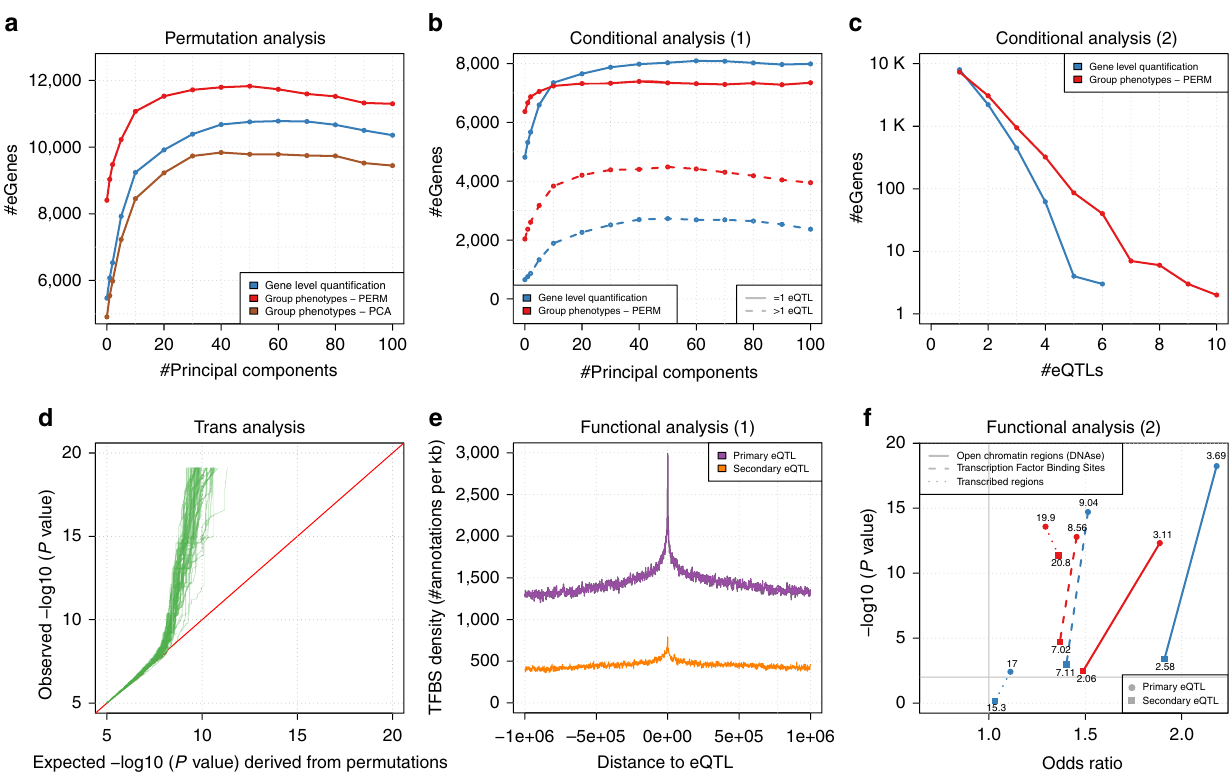
Figure 2 | Outcome of multiple key analyses on Geuvadis. ( a ) The number of eGenes discovered ( y axis) as a function of the number of Principal Components ( x axis) used to correct for technical variance for three different ways of aggregating signal at multiple exons: at the quantification level (in blue) or at the QTL mapping level by using either the extended permutation scheme (in red) or PCA (in brown). ( b ) The numbers of eGenes ( y axis) with a unique eQTL (solid lines) or multiple eQTLs (dotted lines) as a function of the number of principal components ( x axis) used to correct for technical variance. This is shown for two approaches for aggregating the signal at multiple exons: at the quantification level (in blue) or at the QTL mapping level by using the extended permutation scheme (in red). ( c ) The number of eGenes on a log scale ( y axis) as a function of the number of independent eQTLs discovered for those ( x axis). This is again shown for two different approaches for aggregating the signal at multiple exons. ( d ) A Quantile–Quantile plot produced from a trans -QTL analysis on Geuvadis. Each green solid line compares the P values of associations of the original gene expression data to those obtained from a permuted data set. In total, 100 permutations have been performed, resulting in 100 green lines. ( e ) The density of transcription factor binding sites (TFBS) as their number per kb around the positions of two types of eQTLs shown in b (primary and secondary, gene-level quantification). ( f ) The enrichments of the four types of eQTLs shown in b (primary versus secondary, gene quantification versus phenotype grouping) within three types of functional annotations (Methods section). The odd ratios and the (cid:2) log10 of the enrichment P values are shown on the x axis and y axis, respectively. The percentages of eQTLs falling within these annotations are shown next to the corresponding